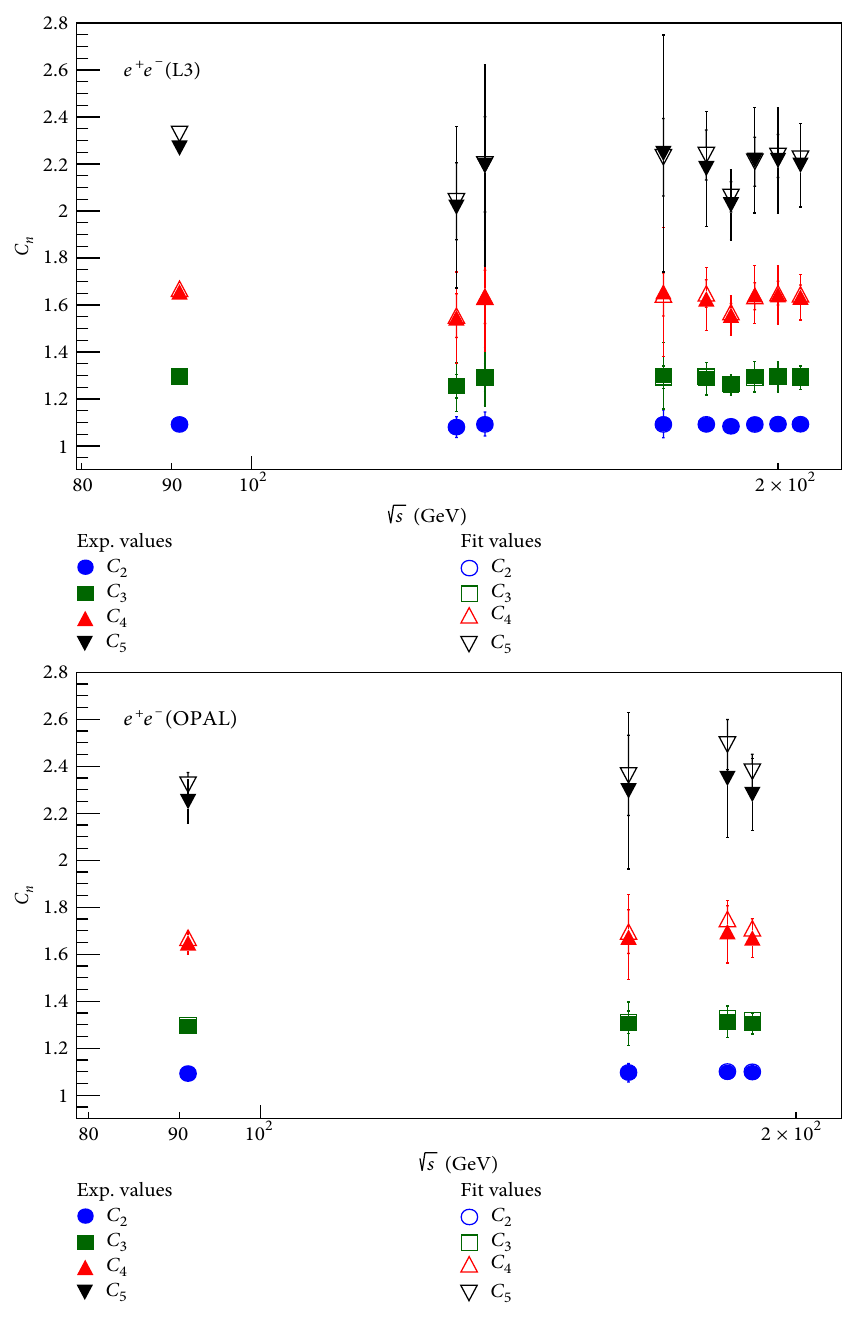
+ − collisions recorded by the L3 and OPAL experiments 𝑒 𝑒